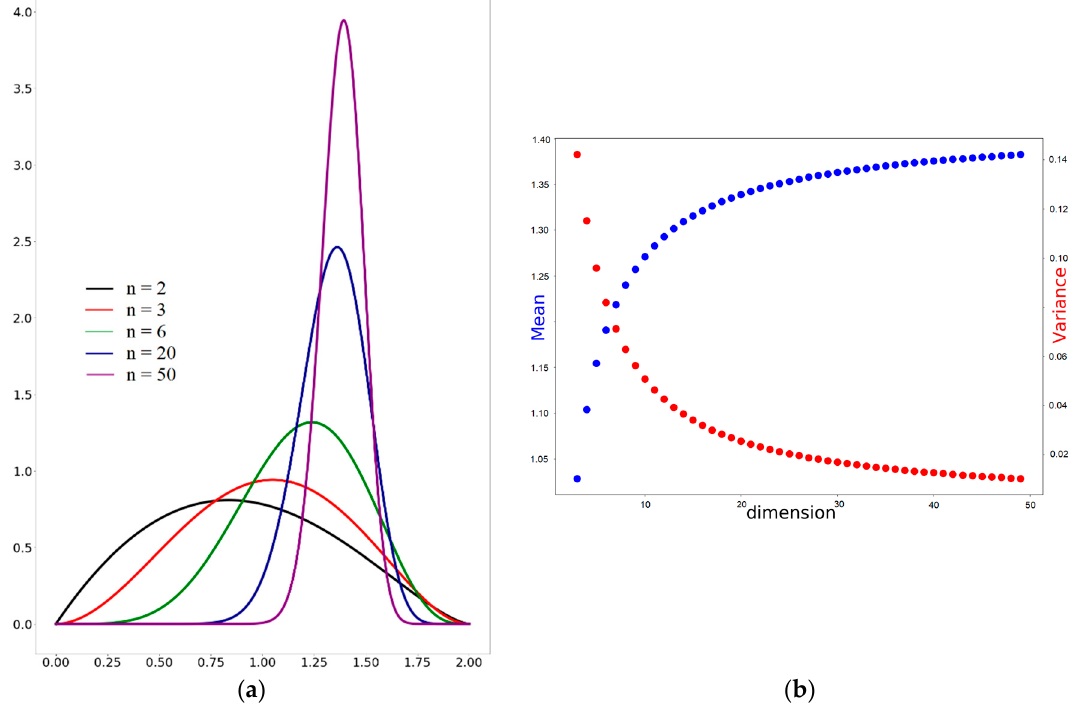
Figure 5. ( a ) Distribution of distances inside a hypersphere ( R = 1) for di ff erent values of space dimension n . ( b ) Mean value of distance tends to R in the